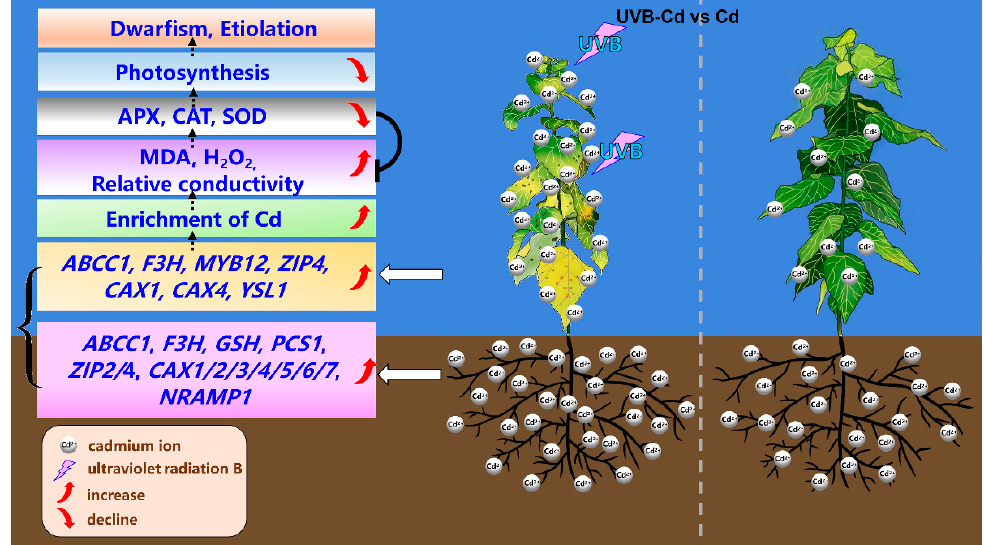
Figure 8. Physiological and molecular mechanisms of UVB Pretreatment enhanced Cd absorption and enrichment in poplar.